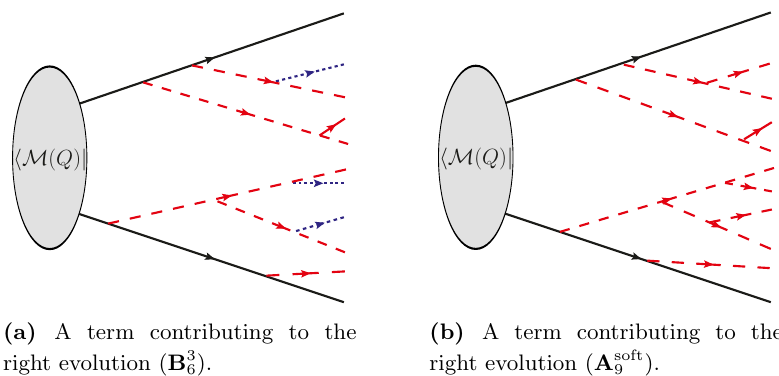
Figure 4. The right evolution (the evolution of the conjugate amplitude) of a hard process after 9 emissions. Red dashed lines represent the emission of soft gluons and collinear emissions are represented by blue dotted lines. Loops (Sudakov factors) have been neglected to avoid